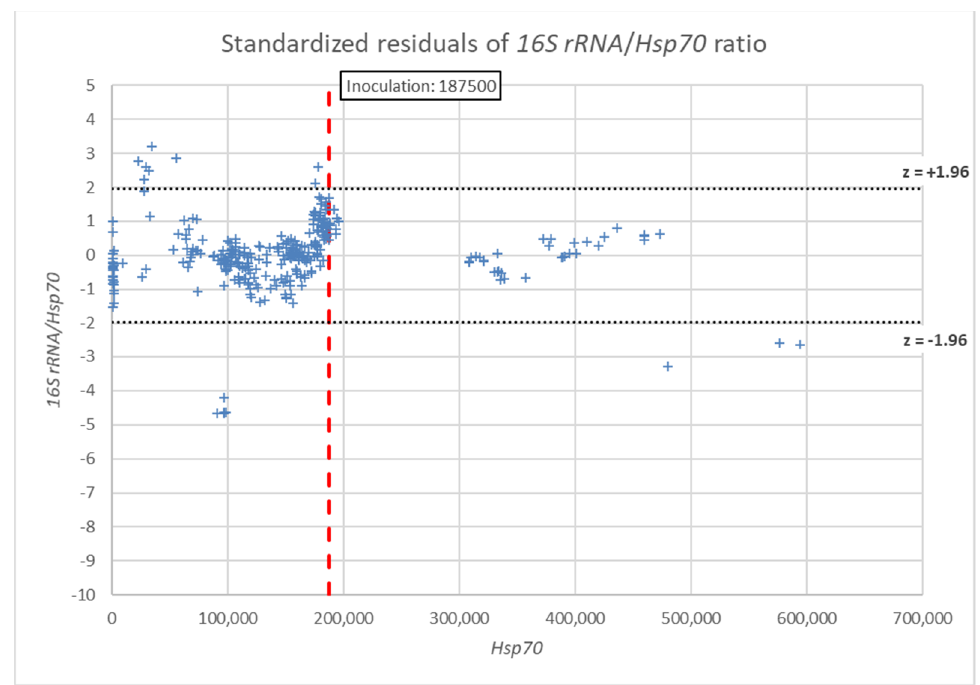
Figure 4. Scatterplot showing the relationship between the error variance of the 16S rRNA/Hsp70 ratio, and the abundance measured with the Hsp70 method (N = 306). Legend-blue crosses: individual standardized residuals, red dashed line: inoculated dose, dotted black lines: 95% interval of the normally distributed data (z = ± 1.96).